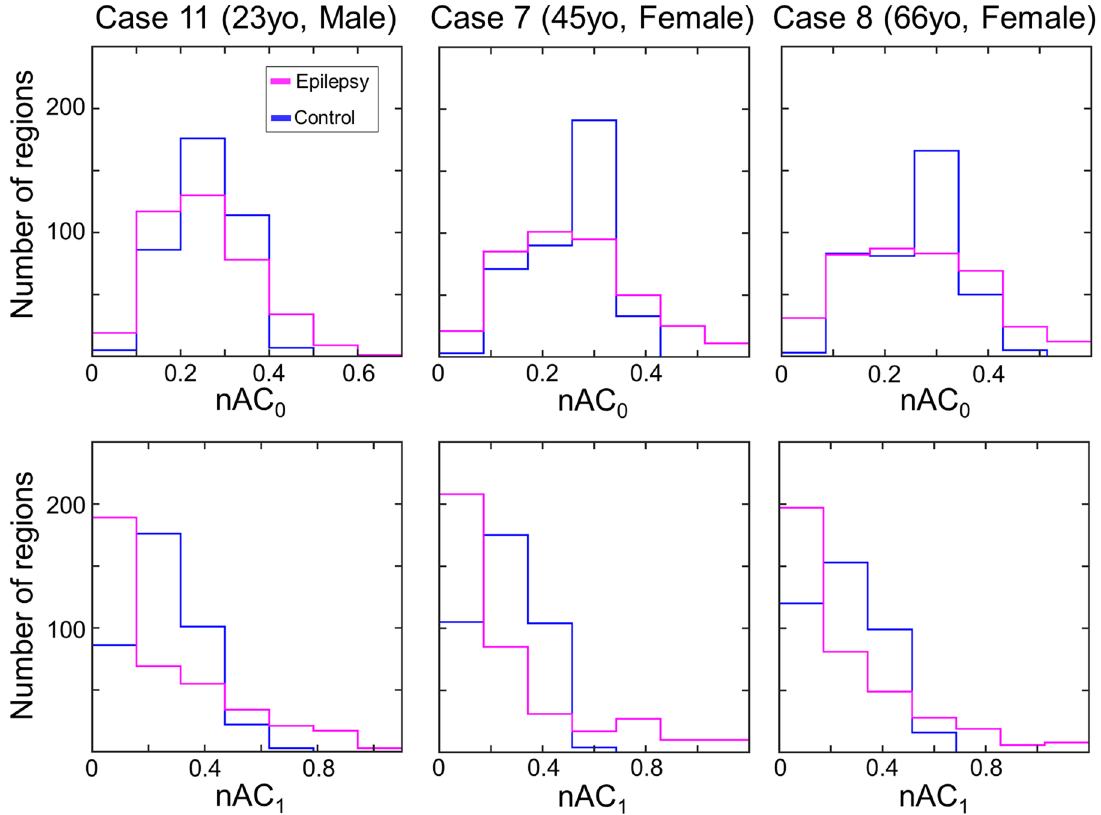
Figure 1. Distributions of nAC values for the patients were different from those for controls. The distributions of nAC 0 and nAC 1 are shown for three representative cases. The number of regions with lower (< 0.2) and higher (> 0.5) values were larger in the epilepsy patients than those for healthy controls, which was the case for all the patients (see Supplementary Fig. S1).